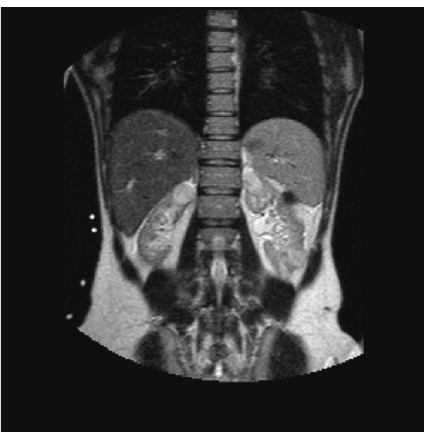
Figure 1: T2-W coronal MR image demonstrates a large right renal mass and numerous left renal masses, some of which were not evident on the US.